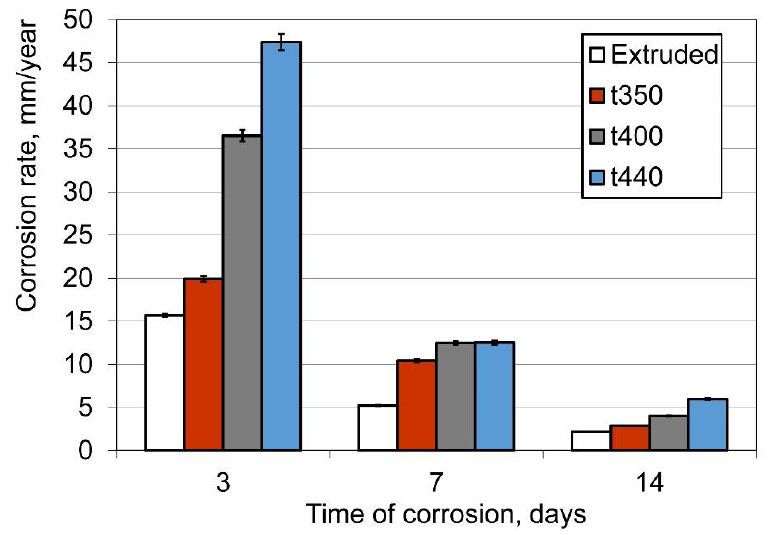
Figure 6. The effects of drawing temperature and the corrosion time on corrosion rate.